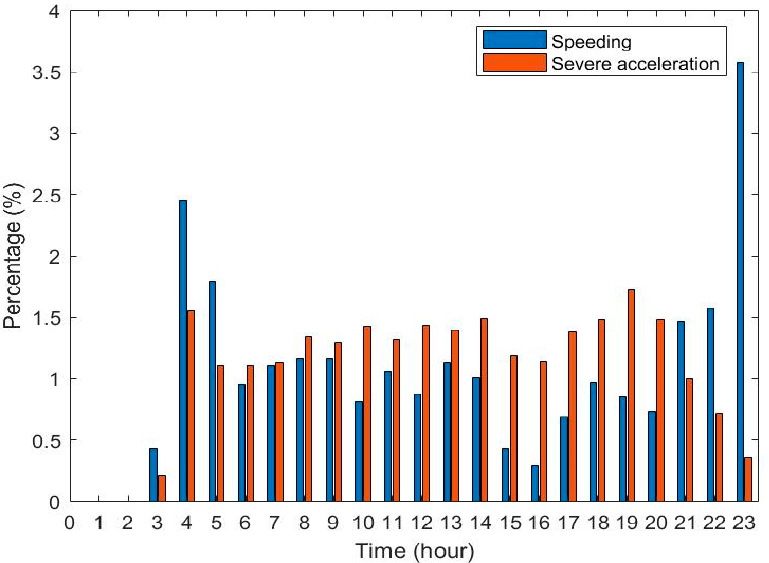
Figure 7. Bus No. xxx speeding and severe accelerations in 24 h of 7 days. The data on 1 January 2016, were selected for a one-day heat-map analysis, as in Figures 8 and